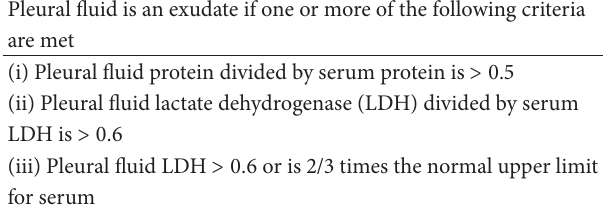
Table 2: Light’s criteria